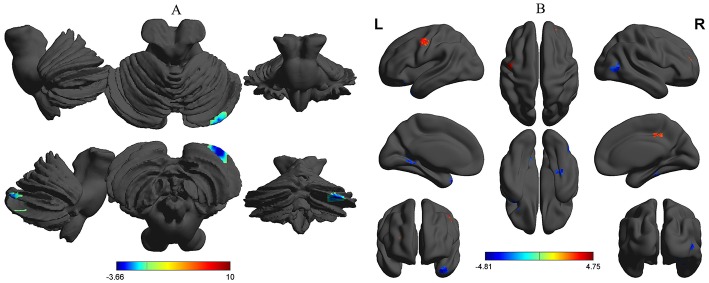
Binarized FCD differences between alcohol dependent and healthy subjects. Between-group differences in binarized longFCD (A) and shortFCD (B). The statistical threshold was set at a corrected significance level of individual two-tailed voxel-wise p < 0.01 using an AlphaSim corrected threshold of cluster p < 0.05. FCD, Functional connectivity density; R, right; L, left; longFCD, Long-range FCD; shortFCD, Short-range FCD.